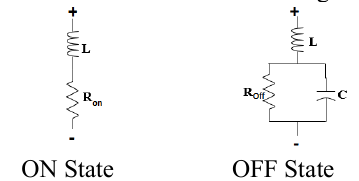
Figure 2: Equivalent circuit model of the p-i-n diode The radiating element is etched with diagonal slot incorporated with p-i-n diodes. The width of the slot is chosen to be 1.8mm based on length of the p-i-n diode used. frequency and are given in Fig. 3.